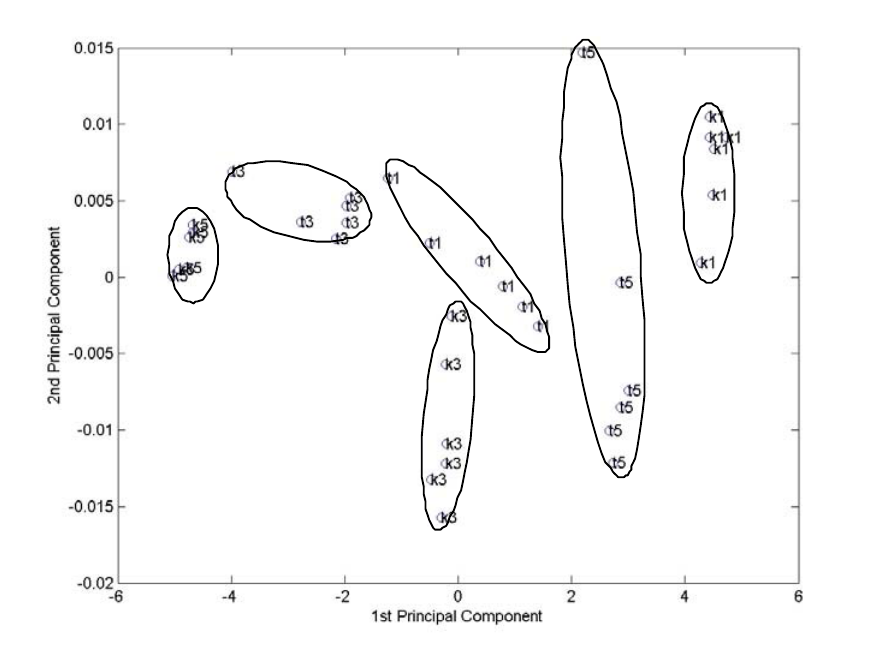
Figure 4. PCA score plot of the pre-processed anodic wave of copper electrode in six Chinese yellow wines mixed with 1 M NaOH